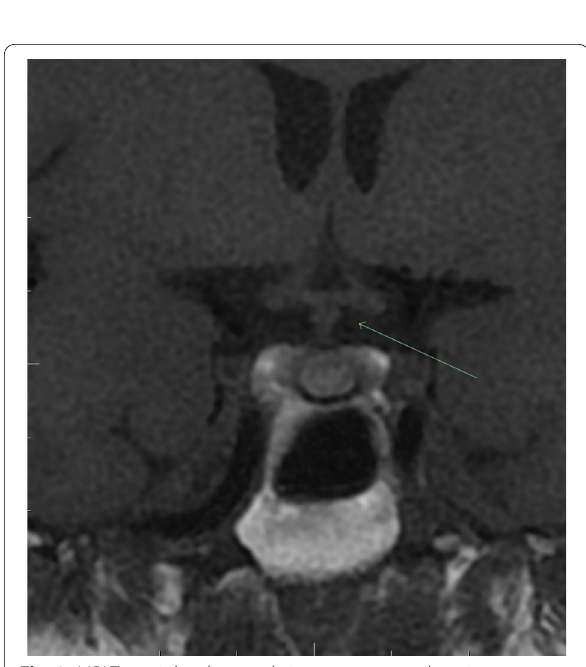
Fig. 3 MRI T1-weighted coronal view same non-enhancing 0.46 0.33 cm pituitary lesion and an arrow indicating the thickening × of the pituitary